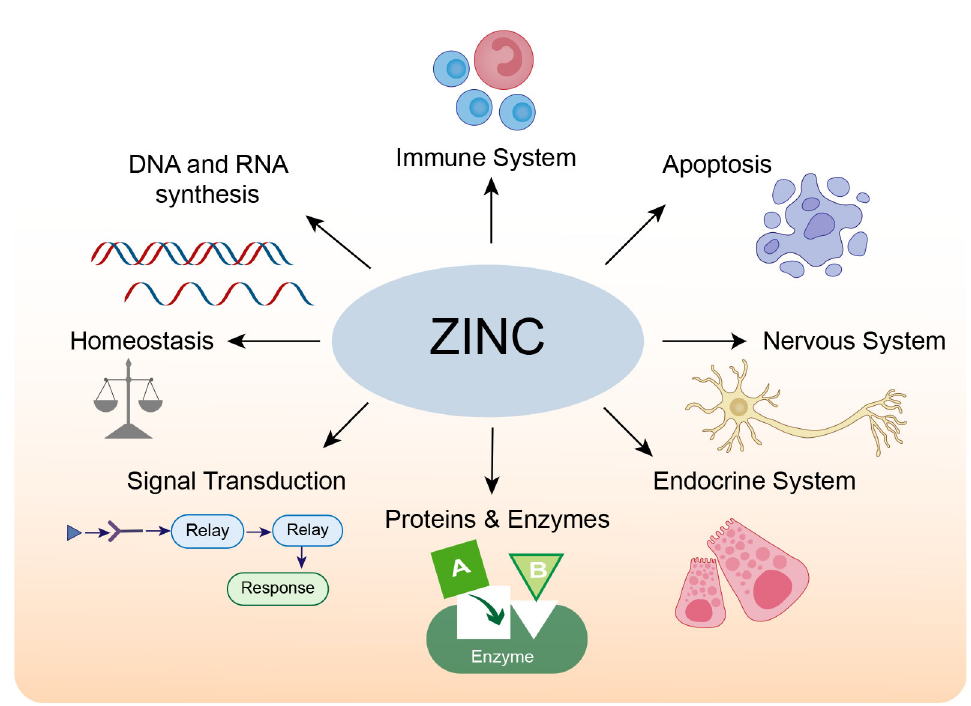
Figure 1. The physiological roles of